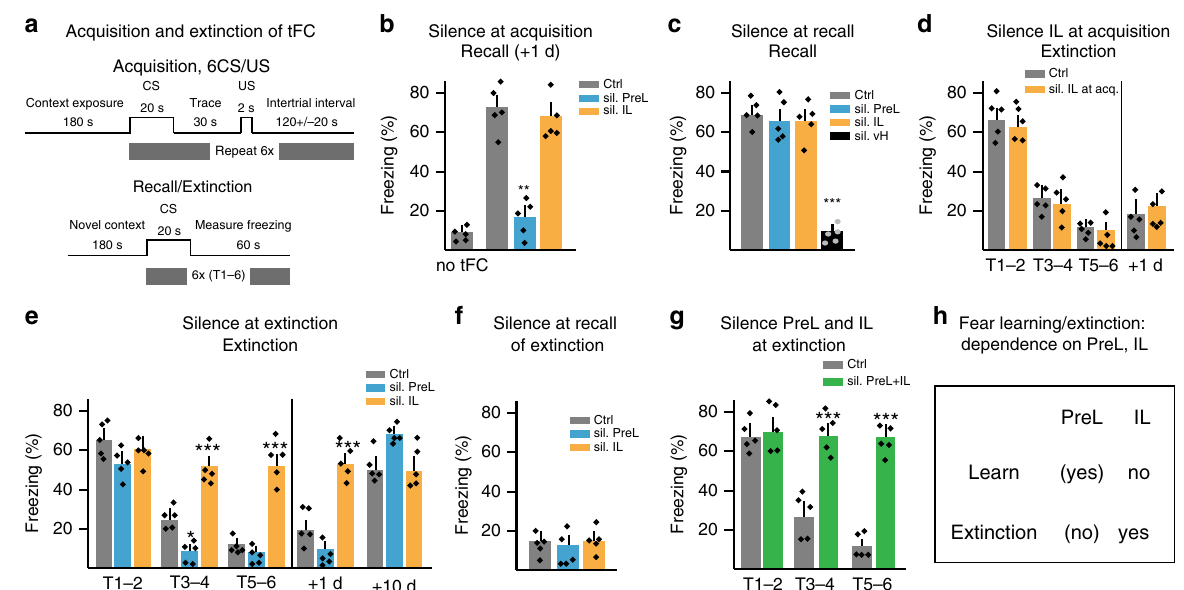
Fig. 4 PreL promotes fear learning and IL drives its extinction. In all these experiments: silencing through pharmacogenetic activation of PV neurons 20 min before learning (or recall); control: vehicle delivery in virus-expressing mice. a Schematic of trace fear conditioning (tFC) and extinction protocol. b Silencing PreL at acquisition impairs freezing at 24 h recall, whereas silencing IL does not ( n = 5 each; one-way ANOVA: F (2, 12) = 20.67, *** P ; Dunnet ’ s post hoc). c Silencing PreL or IL at recall does not affect freezing. In positive control experiments, silencing ventral hippocampus (vH) at recall suppresses freezing ( n = 5 each; one-way ANOVA: F (3, 16) = 31.14, *** P ; Dunnet ’ s post hoc). d Silencing IL at acquisition does not affect extinction learning on the next day ( n = 5 each; repeat measure two-way ANOVA: silence IL, F (1, 4) = 1.01, P = 0.372, ns ). For extinction of tFC, data are shown (here and throughout